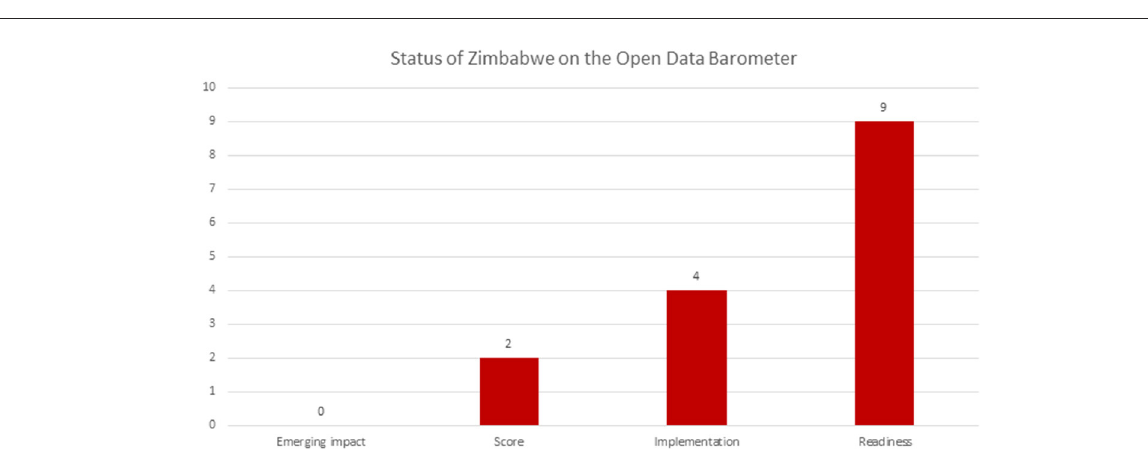
benefits are drawn from the open government data.